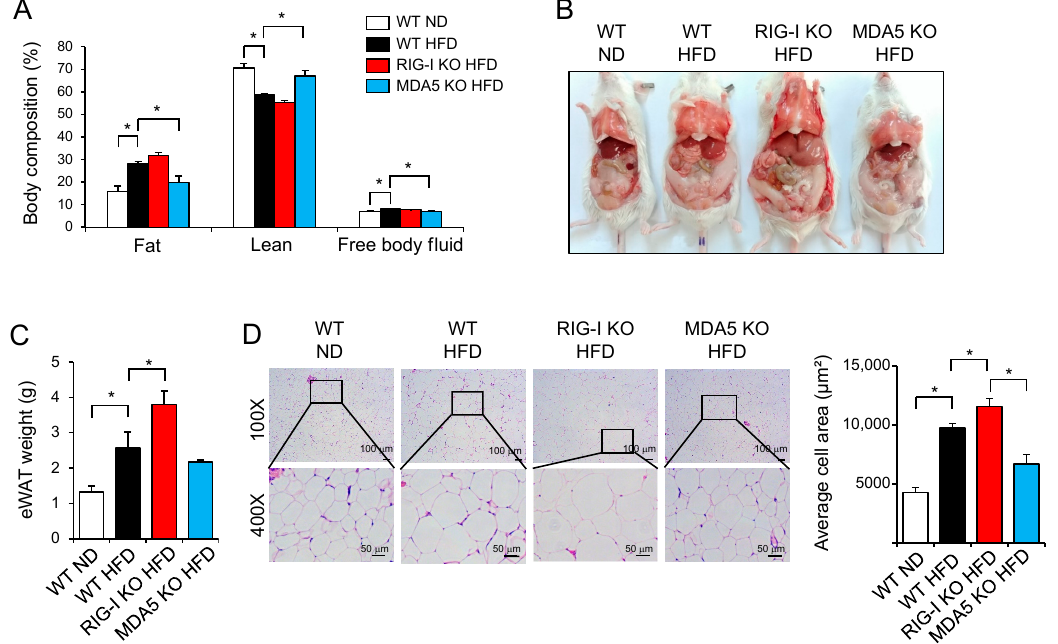
Figure 2. RIG-I deficiency increases fat deposition in mice fed a high-fat diet. ( A ) Body composition was analyzed in mice described in Figure 1. ( B ) Representative pictures of mice at the end of the 12-week experiment. ( C ) Epididymal white adipose tissue (eWAT) weight. ( D ) eWATs were stained with hematoxylin and eosin (H&E) (100 × , 400 × ). Bar graphs represent the average cell size area of each group. The values in bar graphs represent the means ± SEM ( n = 4–5). * p <